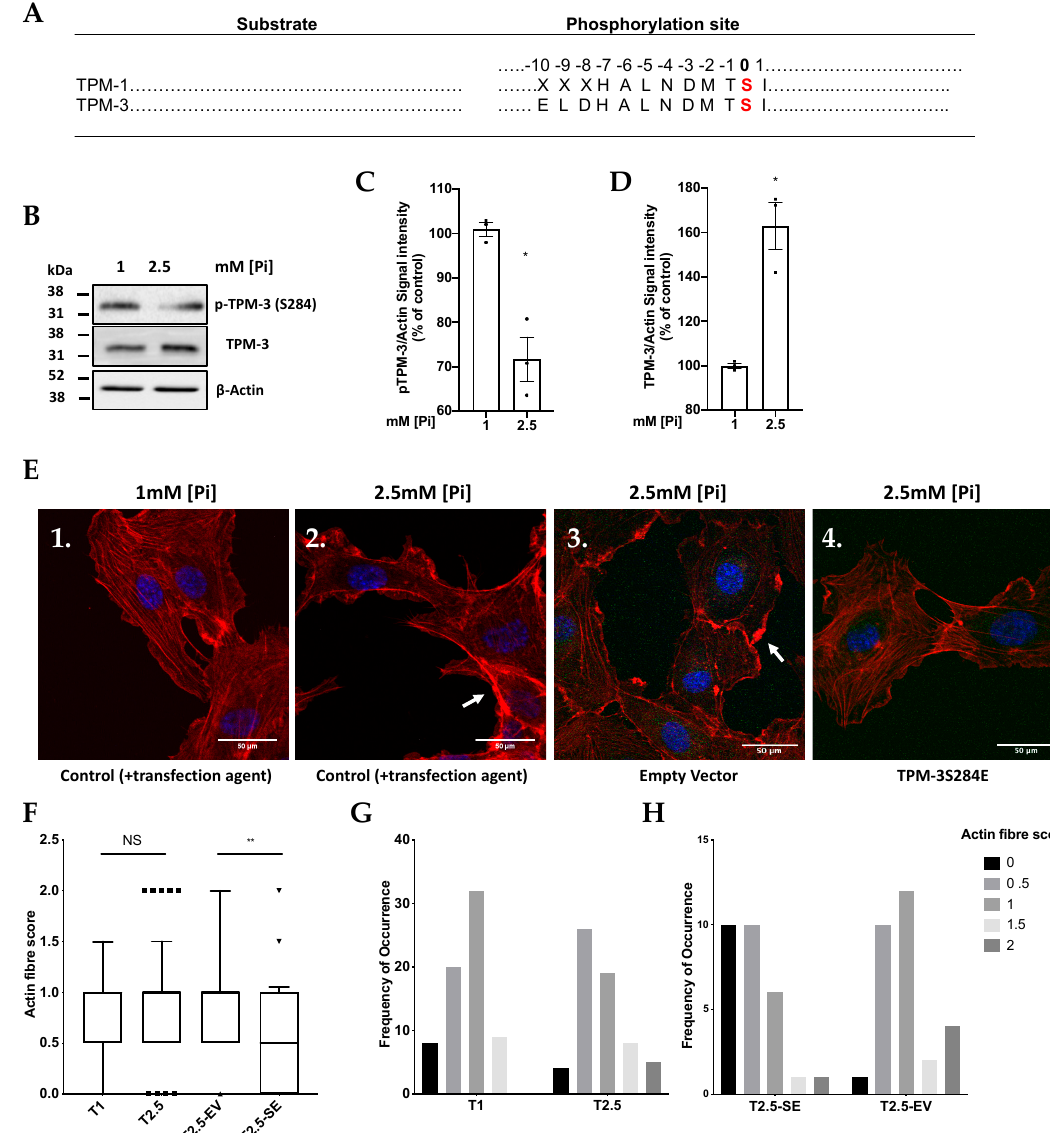
Figure 5. Pi-induced hypophosphorylation of cytoskeletal regulatory protein (TPM-3) resulting in the loss of actin stress-fibre formation which is reversed by overexpression of pseudophosphorylated TPM-3 mutant. ( A ) Sequence alignment of human TPM-1 and TPM-3 showing the amino acid sequence around the phosphorylation site of TPM-3 at the C-terminus. ( B ) p-TPM-3 (S284) and total TPM-3 representative immunoblots obtained from cell lysates using antibodies against TPM-3, and p-(S284)-TPM-3 after treatment of the cells with 1 or 2.5 mM Pi for 1.5 h. ( C , D ) Blots were quantified by densitometry ( n = 3, * p = 0.0337, ** p = 0.0095). ( E ) High Pi-induced hypophosphorylation of TPM-3 after treating the cells with 1 or 2.5 mM [Pi] for 1.5 h is associated with the loss of actin stress fibre formation, but accumulation of cortical actin deposits (Panel 2). In contrast, cultures transfected with plasmid overexpressing pseudophosphorylated TPM-3 mutant (TPM-3S284E) show partial restoration of stress fibres in the presence of 2.5 mM Pi (Panel 4). After cells were treated with 1 or 2.5 mM [Pi] for 1.5 h, they were fixed and stained for F-actin using Alexa-Fluor-594-phalloidin and DAPI and then were examined by confocal microscopy. White arrows show formation of dense actin deposits in the cortical region of the cell. ( F – H ) A quantification from the above experiments was performed ( n = 3, ** p = 0.0021) as detailed in the experimental procedures section. SE: pseudophosphorylated TPM-3 mutant, EV: Empty Vector, NS: Not significant. Actin fibre score data in ( F ) are presented as box and whisker